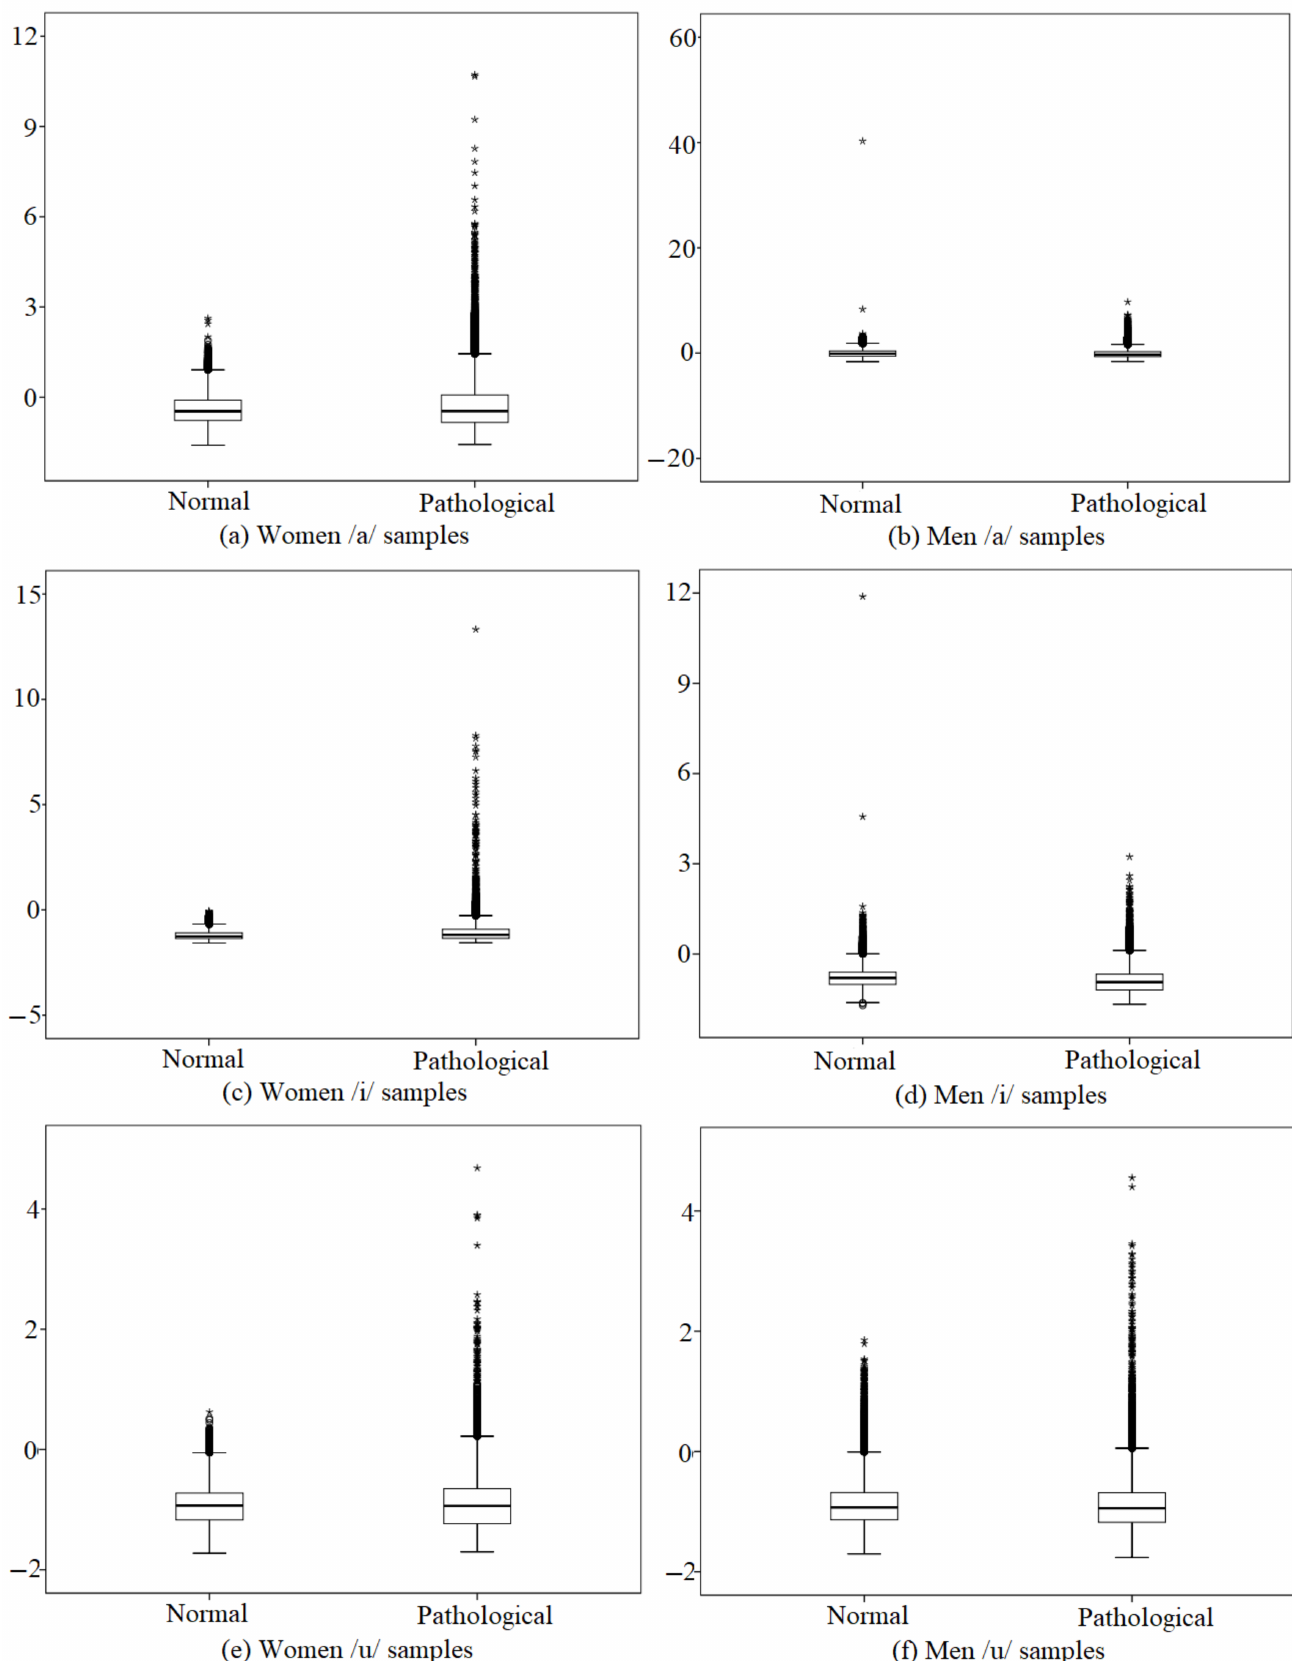
Figure 3. Distributions of normalized kurtosis in each vowel (*: extreme